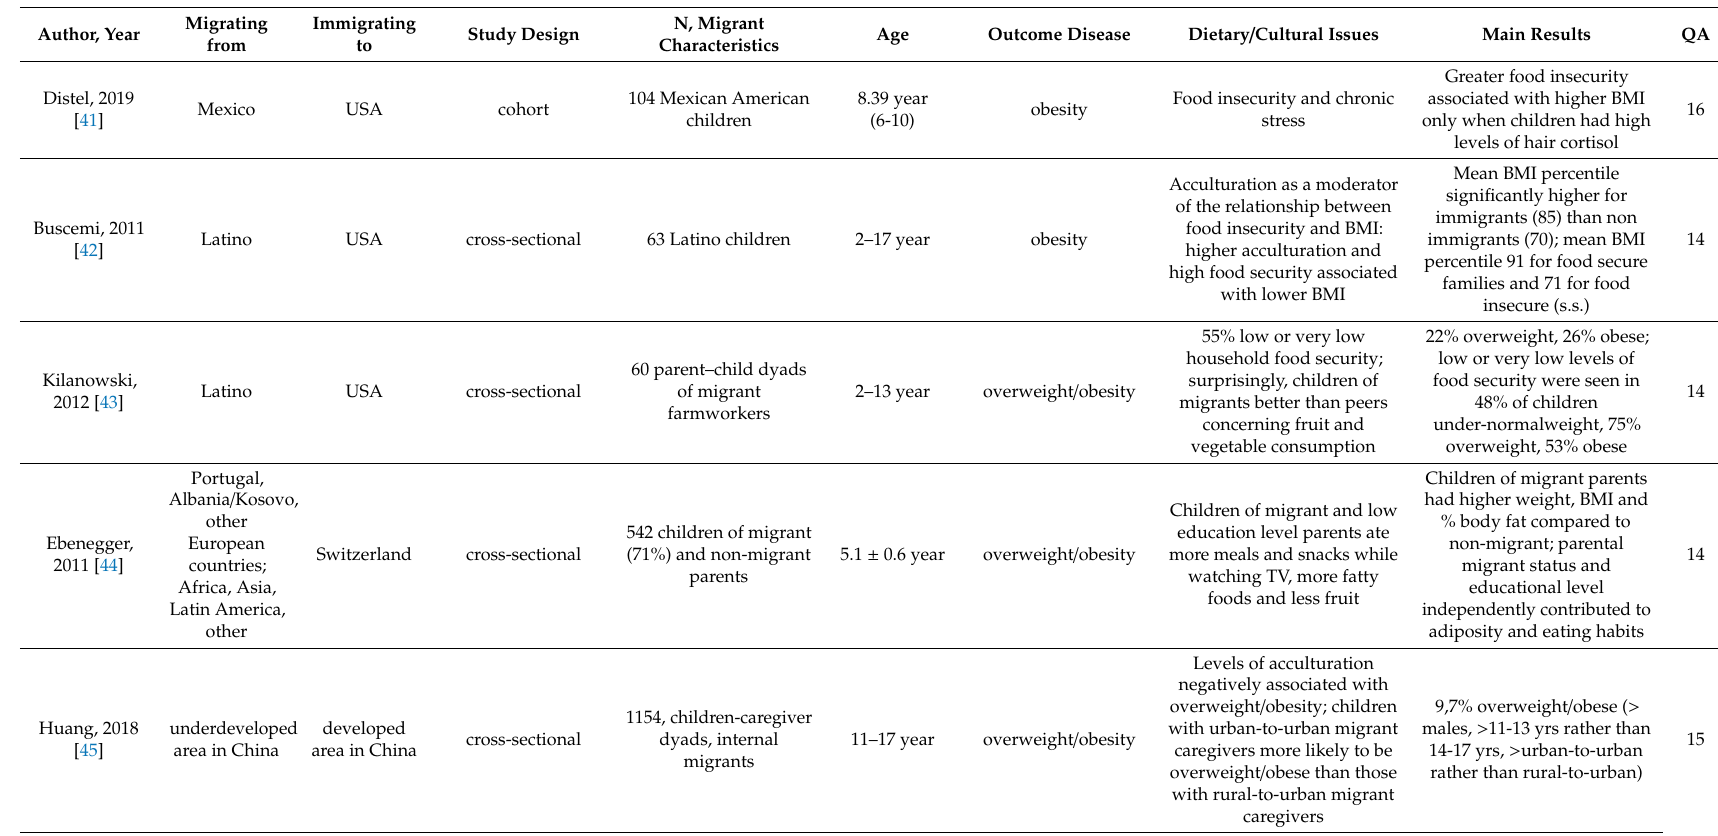
Table 2. Characteristics and main results of the included studies.